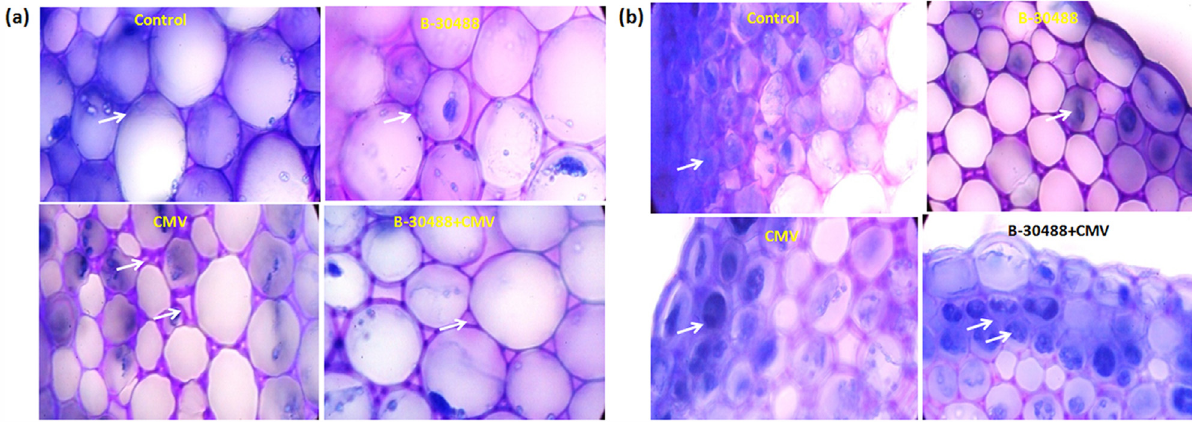
Fig 8. Hisology of stem tissue. Histological analysis of stem tissue of N . tabacum cv. White Burley plants showing effect of PGPR ( P . lentimorbus , B- 30488) in presence and absence of virus (CMV). (a) Healthy collenchyma cells are observed in control, B-30488 and CMV+ B-30488 treatments while CMV infection caused shrinkage of the cells altering the intercellular space (shown by the arrows) and thickened cell connecting corners (b) Stem tissue showing polyphenol accumulation in hypodermis layer (shown by arrows). All the pictures were taken at 100X